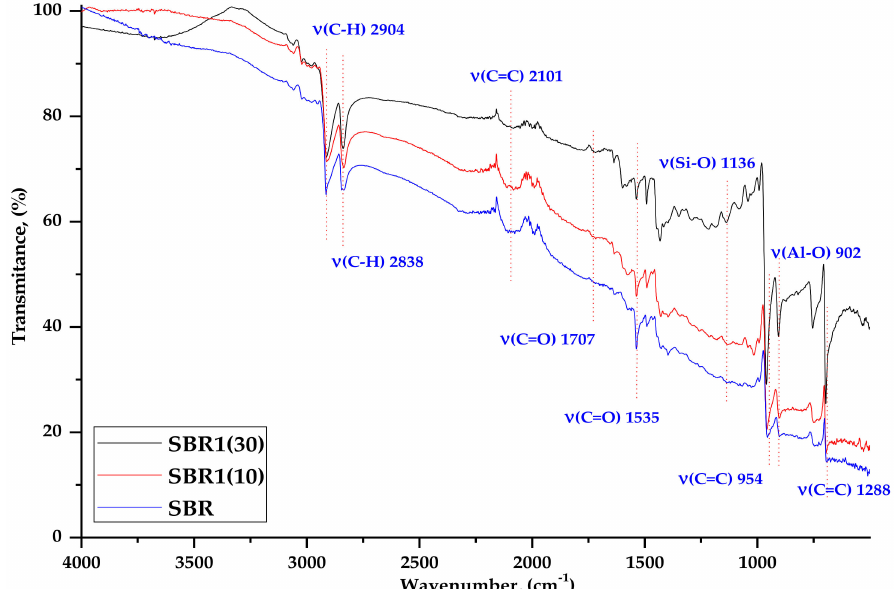
Figure 4. FTIR spectra of SBR, SBR1 (10), and SBR1 (30) composites.